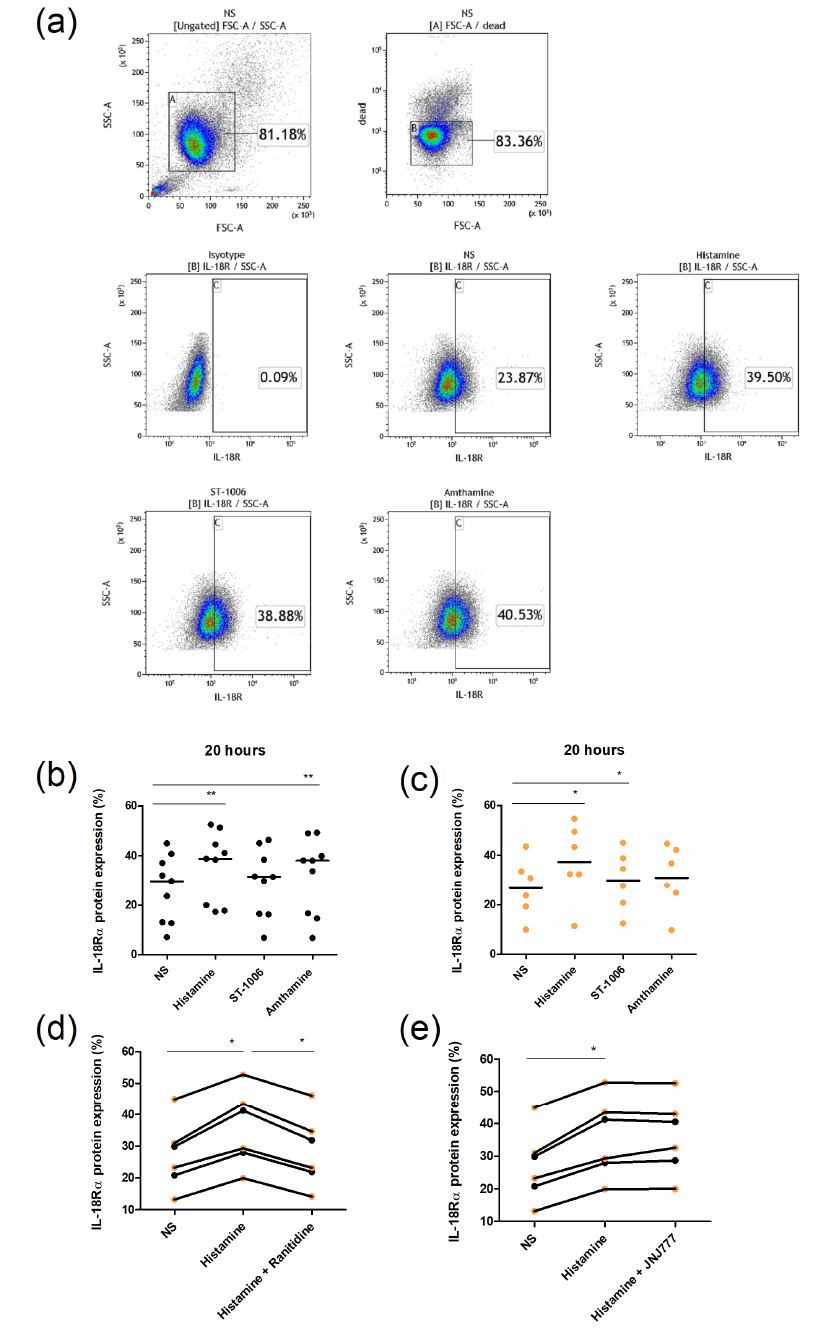
Figure 3. IL-18Rα protein expression upon stimulation with histamine, ST-1006, and amthamine. The expression level of the IL-18Rα on purified eosinophils was measured by flow cytometry. ( a ) Eosinophils from one representative donor were gated based on forward scatter (FSC) and side scatter (SSC) (A). Dead cells were labeled with the dye 7-AAD and excluded from the analysis by gate B. Gate C for IL-18Rα positive cells was set based on the isotype control. ( b , c ) Eosinophils from AD patients (black) and healthy controls (orange) were stimulated with histamine (10 μmol/L), the H 4 R agonist ST-1006 (10 μmol/L), or the H 2 R agonist amthamine (10 μmol/L) for 20 h or left unstimulated (NS). ( d , e ) For blocking experiments, the H 4 R antagonist JNJ7777120 (10 μmol/L) and the H 2 R antagonist ranitidine (10 μmol/L) were added 30 min before histamine. For statistical analysis, a Wilcoxon signed rank test was applied. * p -value < 0.05; ** p -value < 0.1. NS—not stimulated.